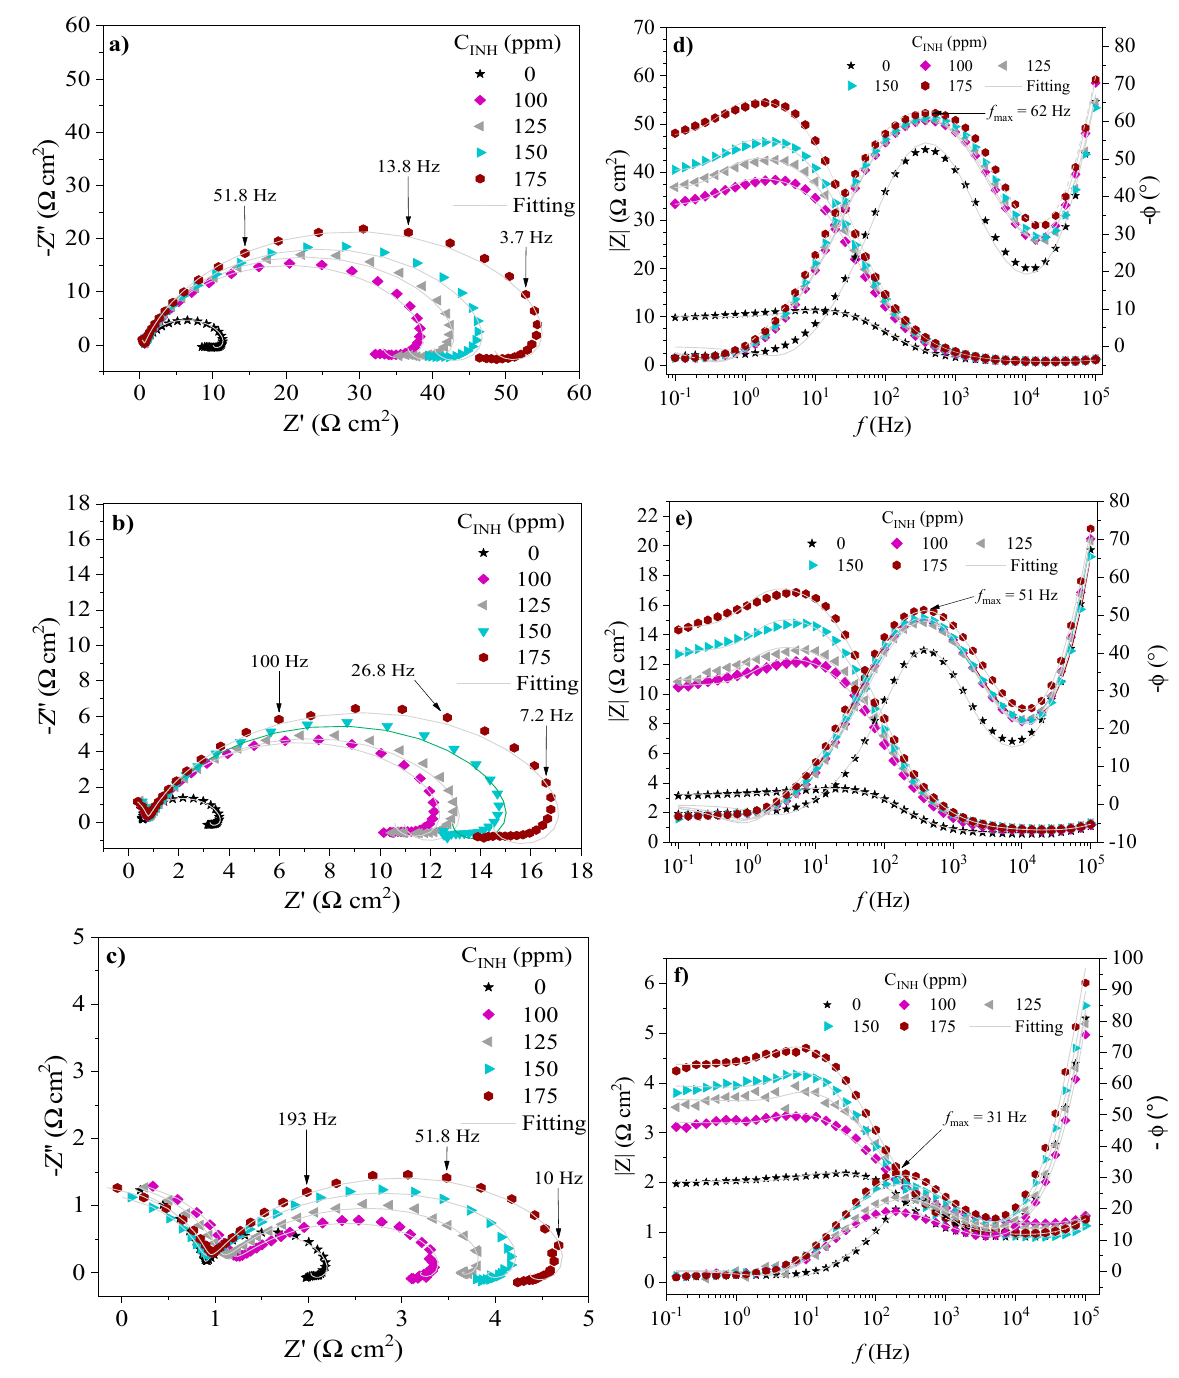
Figure 9. EIS spectra of API 5L X60 steel in 1 M H 2 SO 4 in the presence of Poly[VIMC4][Br]: Nyquist [( a ) 308 K, ( b ) 318 K and ( c ) 328 K] and Bode [( d ) 308 K, ( e ) 318 K and ( f ) 328 K].